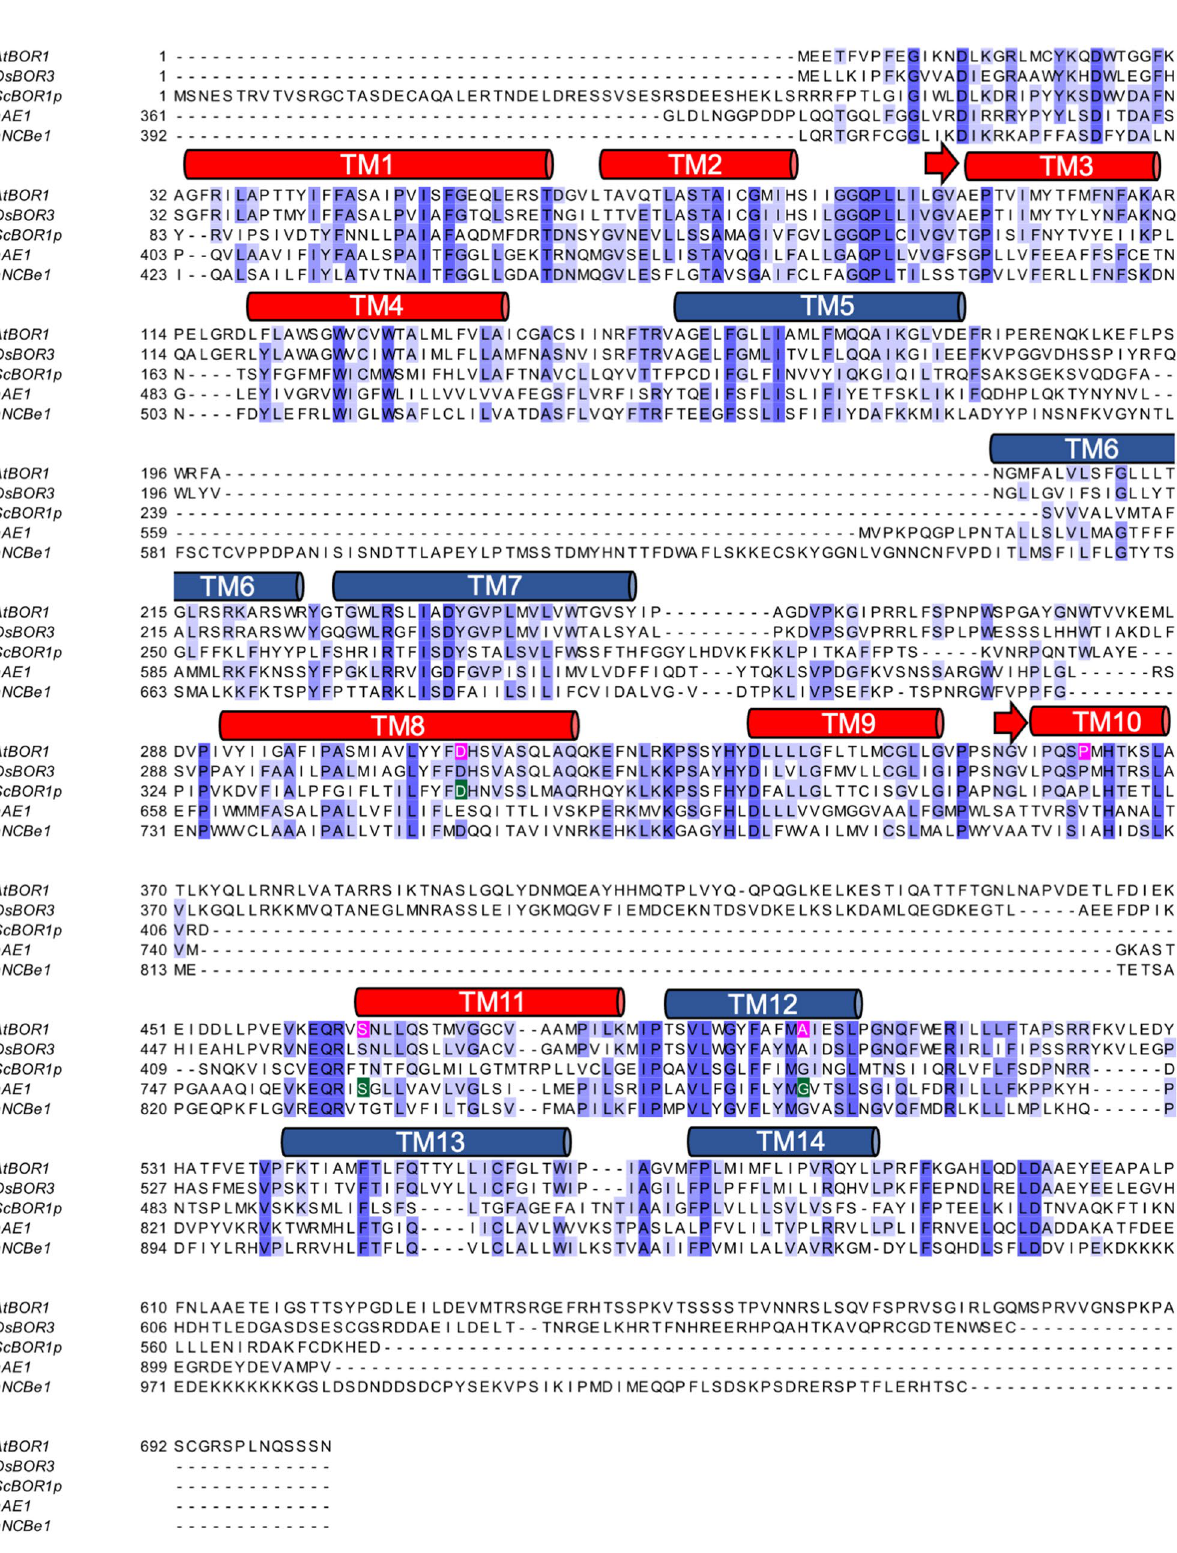
Figure 1. Protein sequence alignment of SLC4 family members. AtBOR1 (Acc. Code: OAP07993.1), OsBOR3 (Acc. Code: AK072421), hAE1 (Acc. Code: NP_000333.1), hNBCe1 (Acc Code: NP_003750.1). Only the TM domains of hAE1 and hNBCe1 are aligned with the full length plant BOR proteins. The approximate positions of the TM domains based on the X-ray crystal structure of AtBOR1 (PDB 5L25) are indicated in the cylinders above the sequence. The TM domains are coloured with the helices comprising the core domain in red and the helices comprising the gate domain in blue. The positions of the single point mutations introduced in AtBOR1 are indicated in